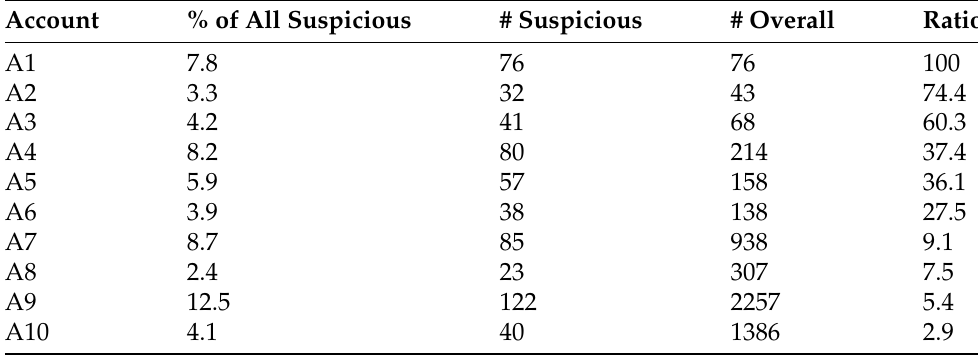
Table 2. Number of suspicious edits, sorted by the ratio of suspicious edits to all